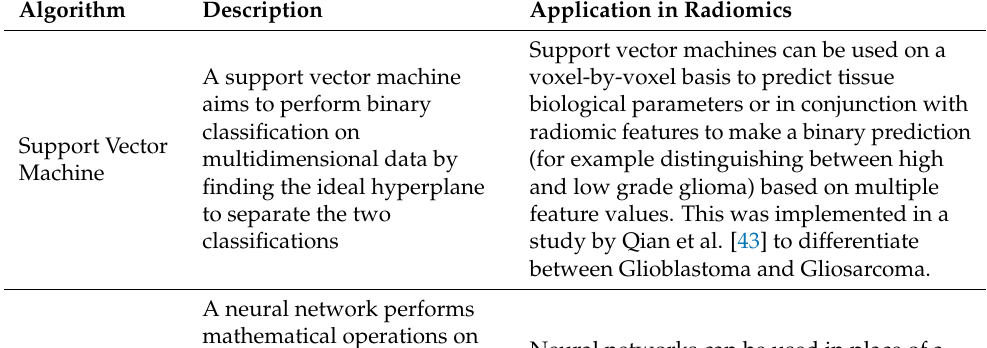
Table 1. A summary of ML algorithms used in radiomics